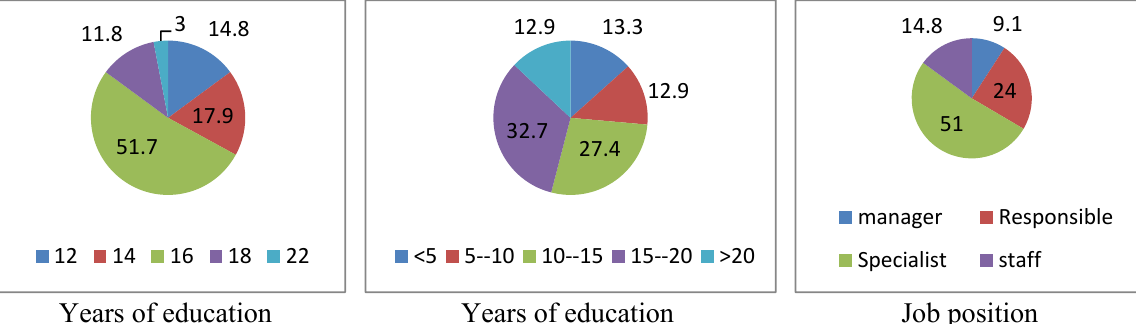
Fig. 2. Personal characteristics of the